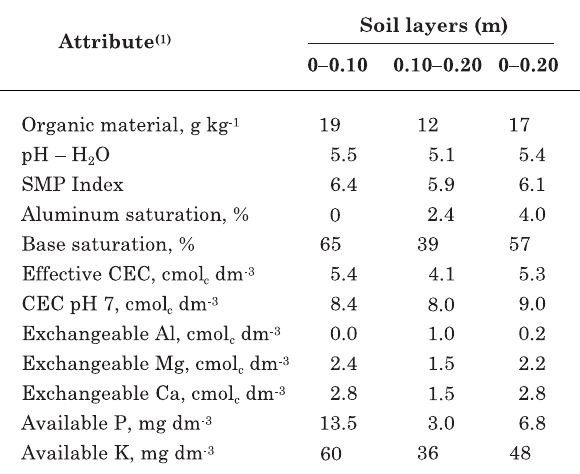
Table 1. Chemical attributes in an Oxisol under the no-till system before implantation of the